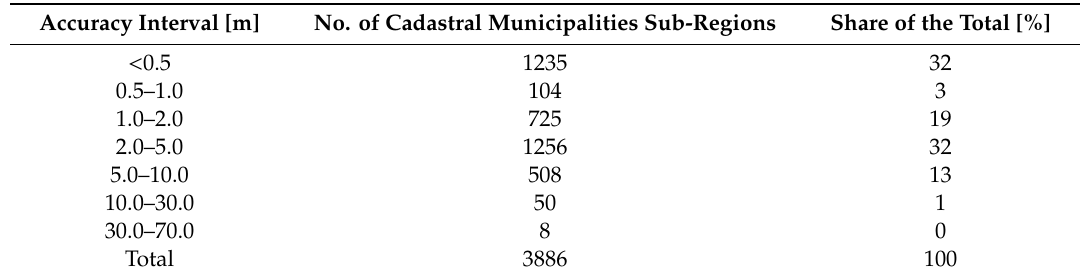
Table 1. Frequency distribution of the accuracy of the digital cadastral index map points in 2003 (Data Source: Geodetic Institute of